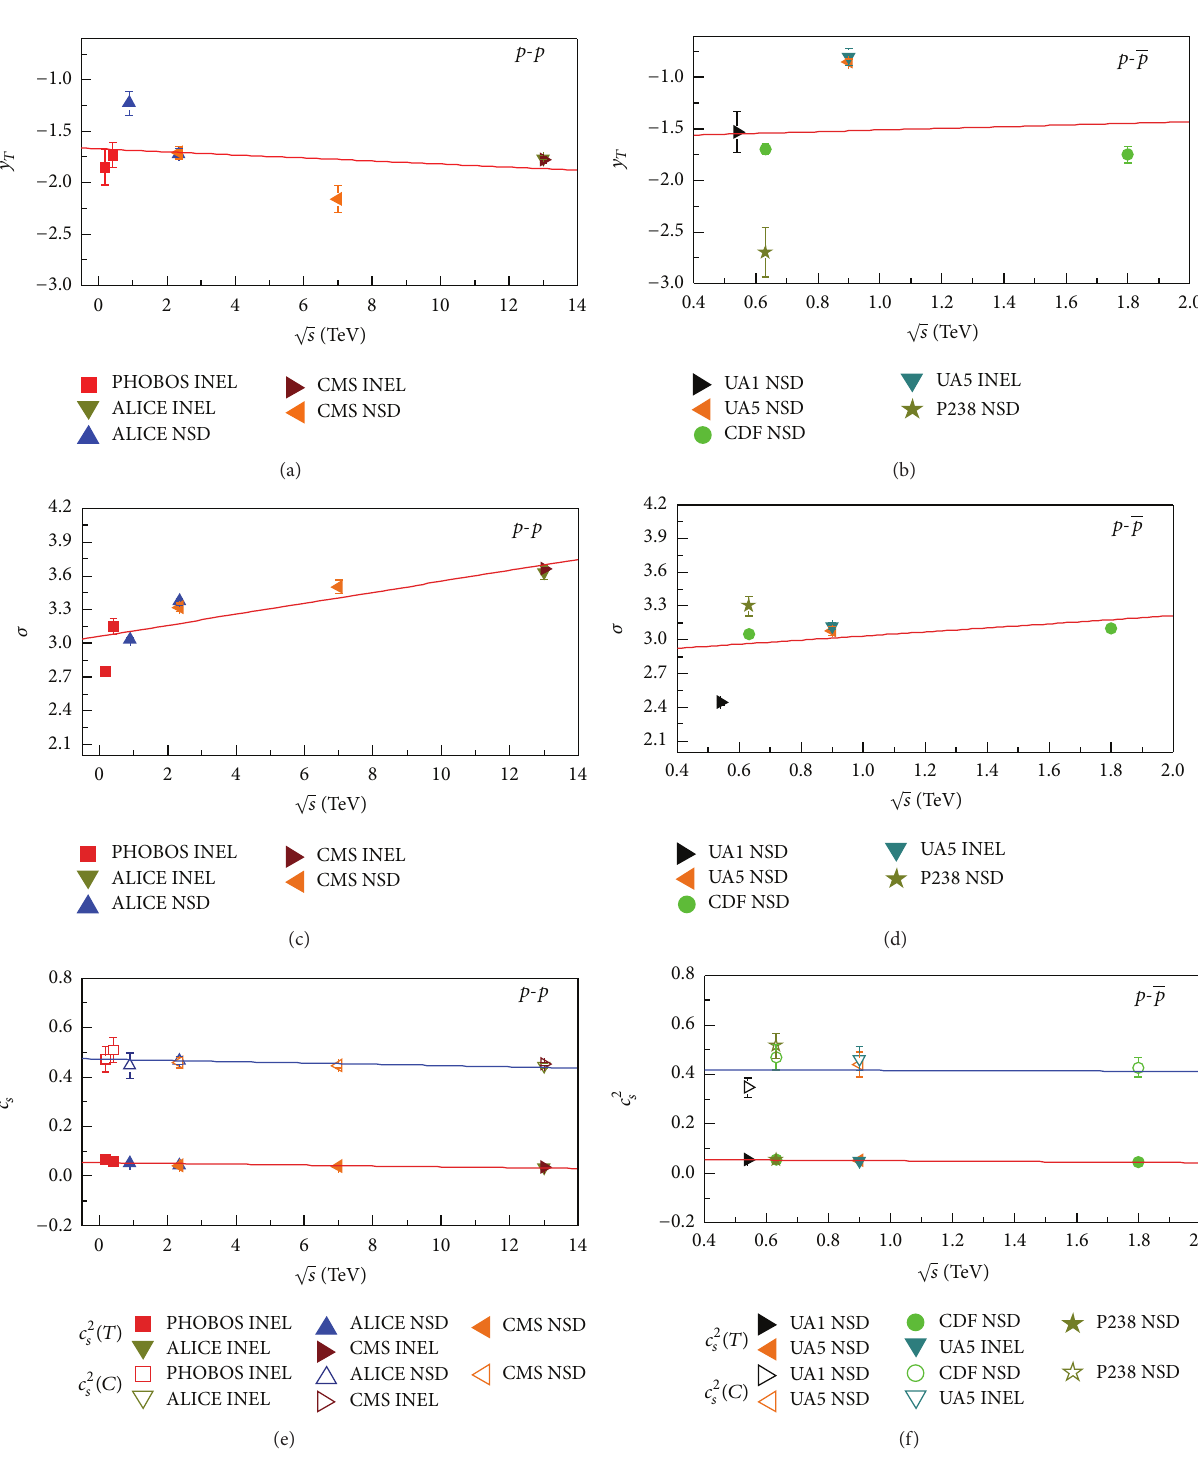
Figure 3: Collision energy dependence of 𝑦 𝑇 ((a), (b)), 𝜎 ((c), (d)), 𝑐 2 𝑠 (𝑇) ((e), (f)), and 𝑐 2 𝑠 (𝐶) ((e), (f)) for 𝑝 - 𝑝 ((a), (c), (e)) and 𝑝 - 𝑝 ((b), (d), (f)) collisions. The symbols represent the values of free parameters and squared speed-of-sound listed in Table 1. The lines are our fitted results, though some of them do not obey linear